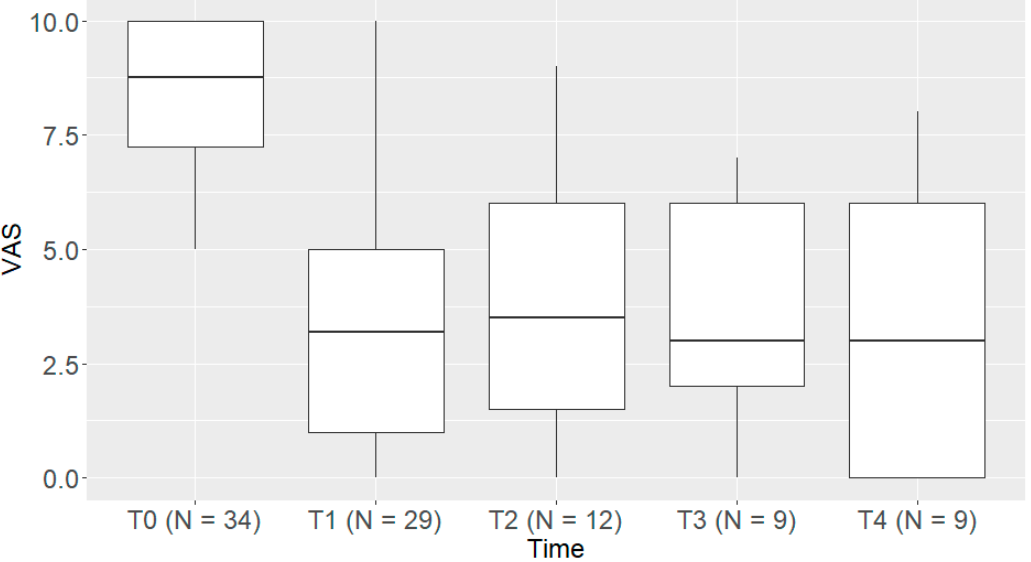
Figure 3. The VAS level changes pre- and post-DBS and numbers of patients when longer follow-up periods were considered: T0 (baseline), T1 (3 months), T2 (12–24 months), T3 (24–47 months), and T4 ( ≥ 48 months). The boxplot shows the median, the upper and lower quartiles, and the two whiskers. The upper whisker extends from the upper quartile to the largest value no further than 1.5 × IQR from the upper quartile, where IQR is the inter-quartile range, or distance between the upper and lower quartiles. The lower whisker has an analogous definition.